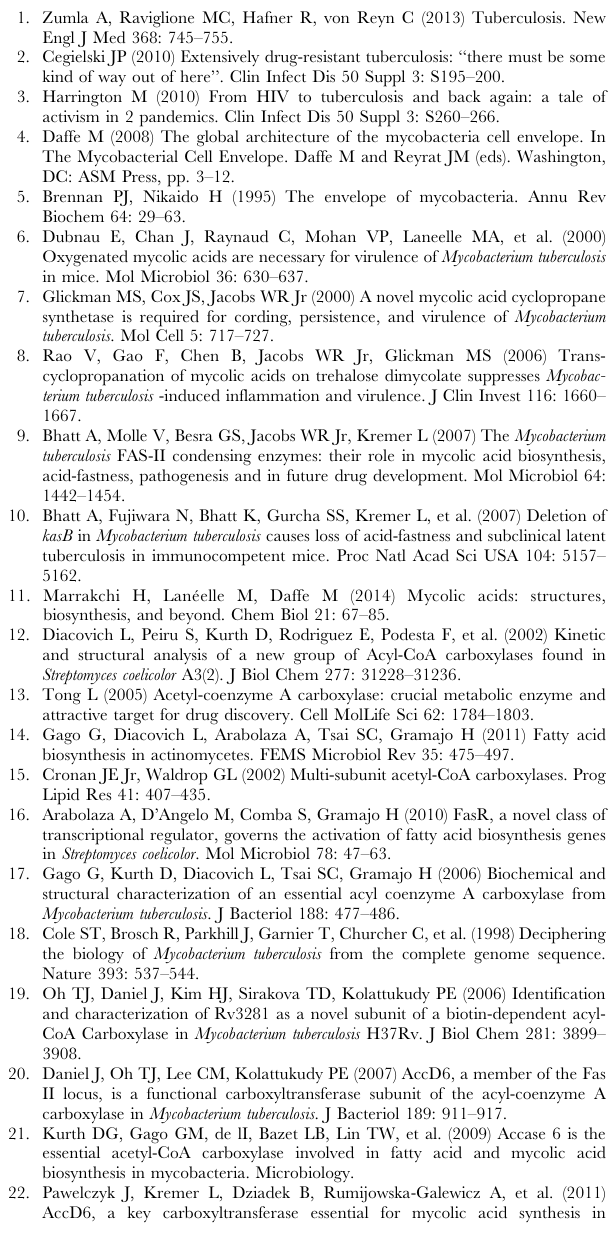
corresponding to the 5 9 region of accD5 . M. smegmatis mc 2 155 DNA (wt) and D5SCO6 (SCO) DNA were included as a control. Molecular masses are indicated in kilobases. Figure S3 Fatty and mycolic acid profiles in D5 MUT. At the indicated times, aliquots from D5 MUT cultures incubated in absence or presence of ATc were labelled with [ 14 C]-acetate for 1 hour at 37 u C. Fatty acid and mycolic acid methyl esters were extracted from D5 MUT and equal amount of radioactivity (40000 cpm) were loaded in each